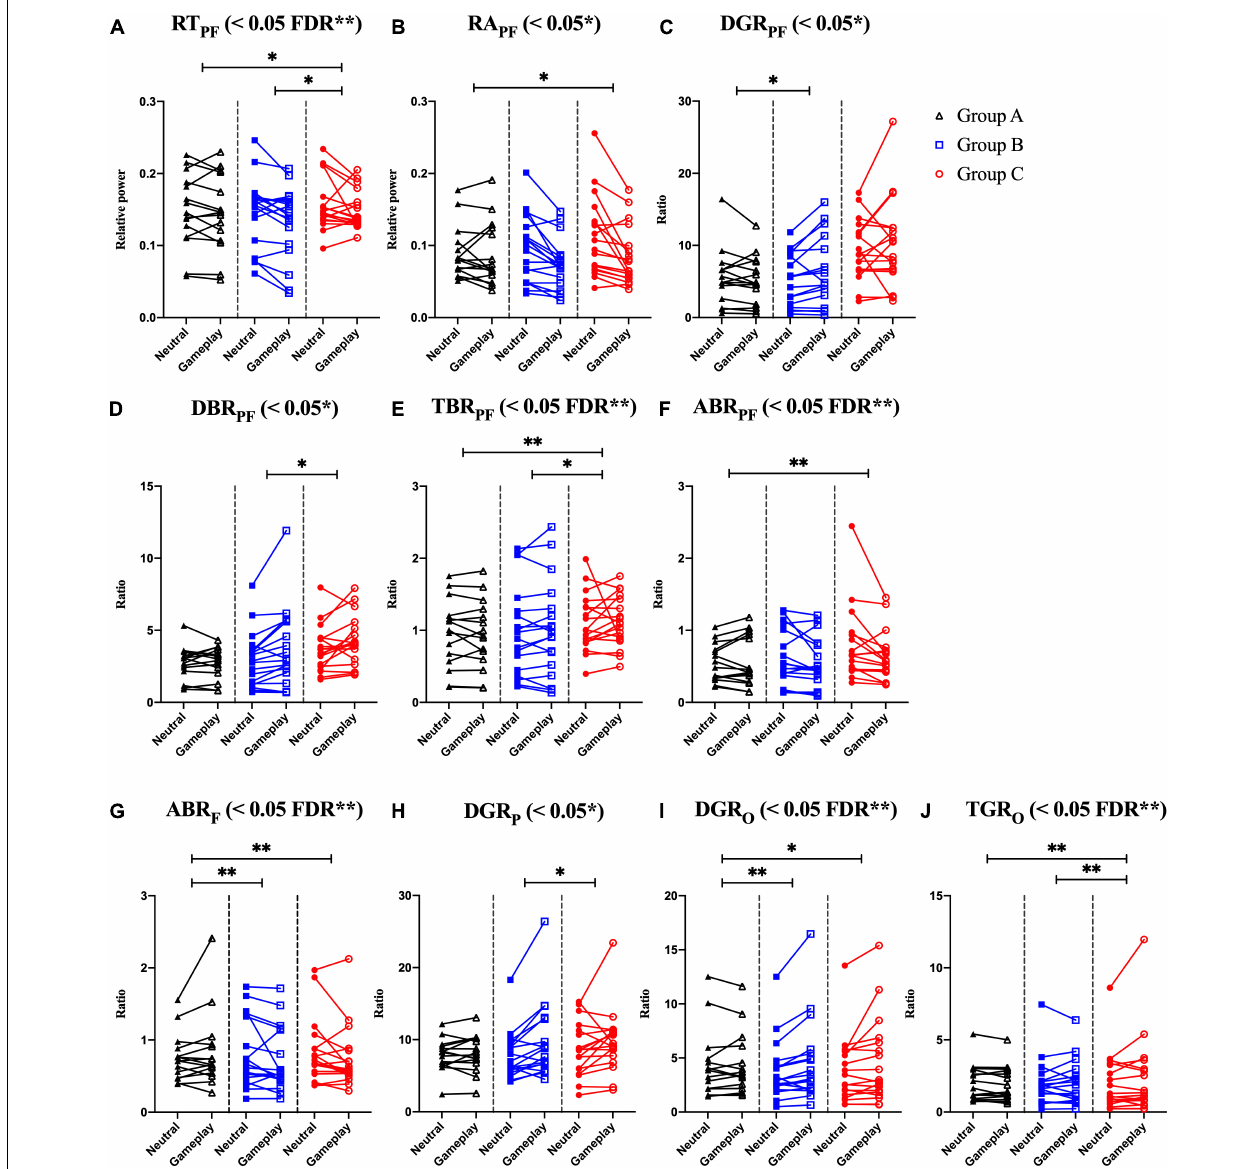
FIGURE 6 | Symbols and lines plot for analysis of covariance with significant results of electroencephalogram features. (A) Prefrontal relative theta power (RT PF ). (B) Prefrontal relative alpha power (RA PF ). (C) Prefrontal delta/gamma ratio (DGR PF ). (D) Prefrontal delta/beta ratio (DBR PF ). (E) Prefrontal theta/beta ratio (TBR PF ). (F) Prefrontal alpha/beta ratio (ABR PF ). (G) Frontal alpha/beta ratio (AB RF ). (H) Parietal delta/gamma ratio (DGR P ). (I) Occipital delta/gamma ratio (DGR O ). (J) Occipital theta/gamma ratio (TGR O ). * p < 0.05, ** p < 0.01 ( post-hoc of analysis of covariance with Bonferroni correction). And FDR ** p < 0.05 with FDR correction for analysis of